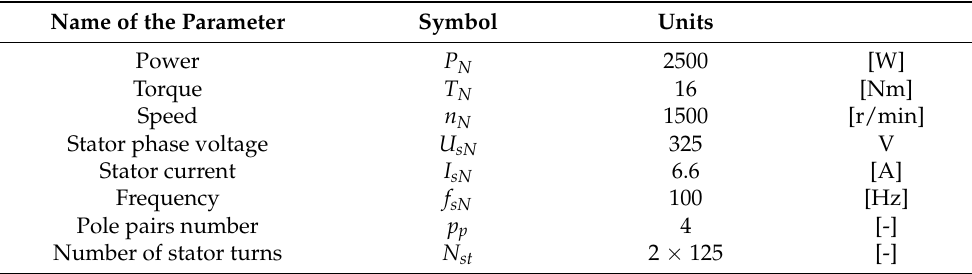
Table A1. Rated parameters of the tested